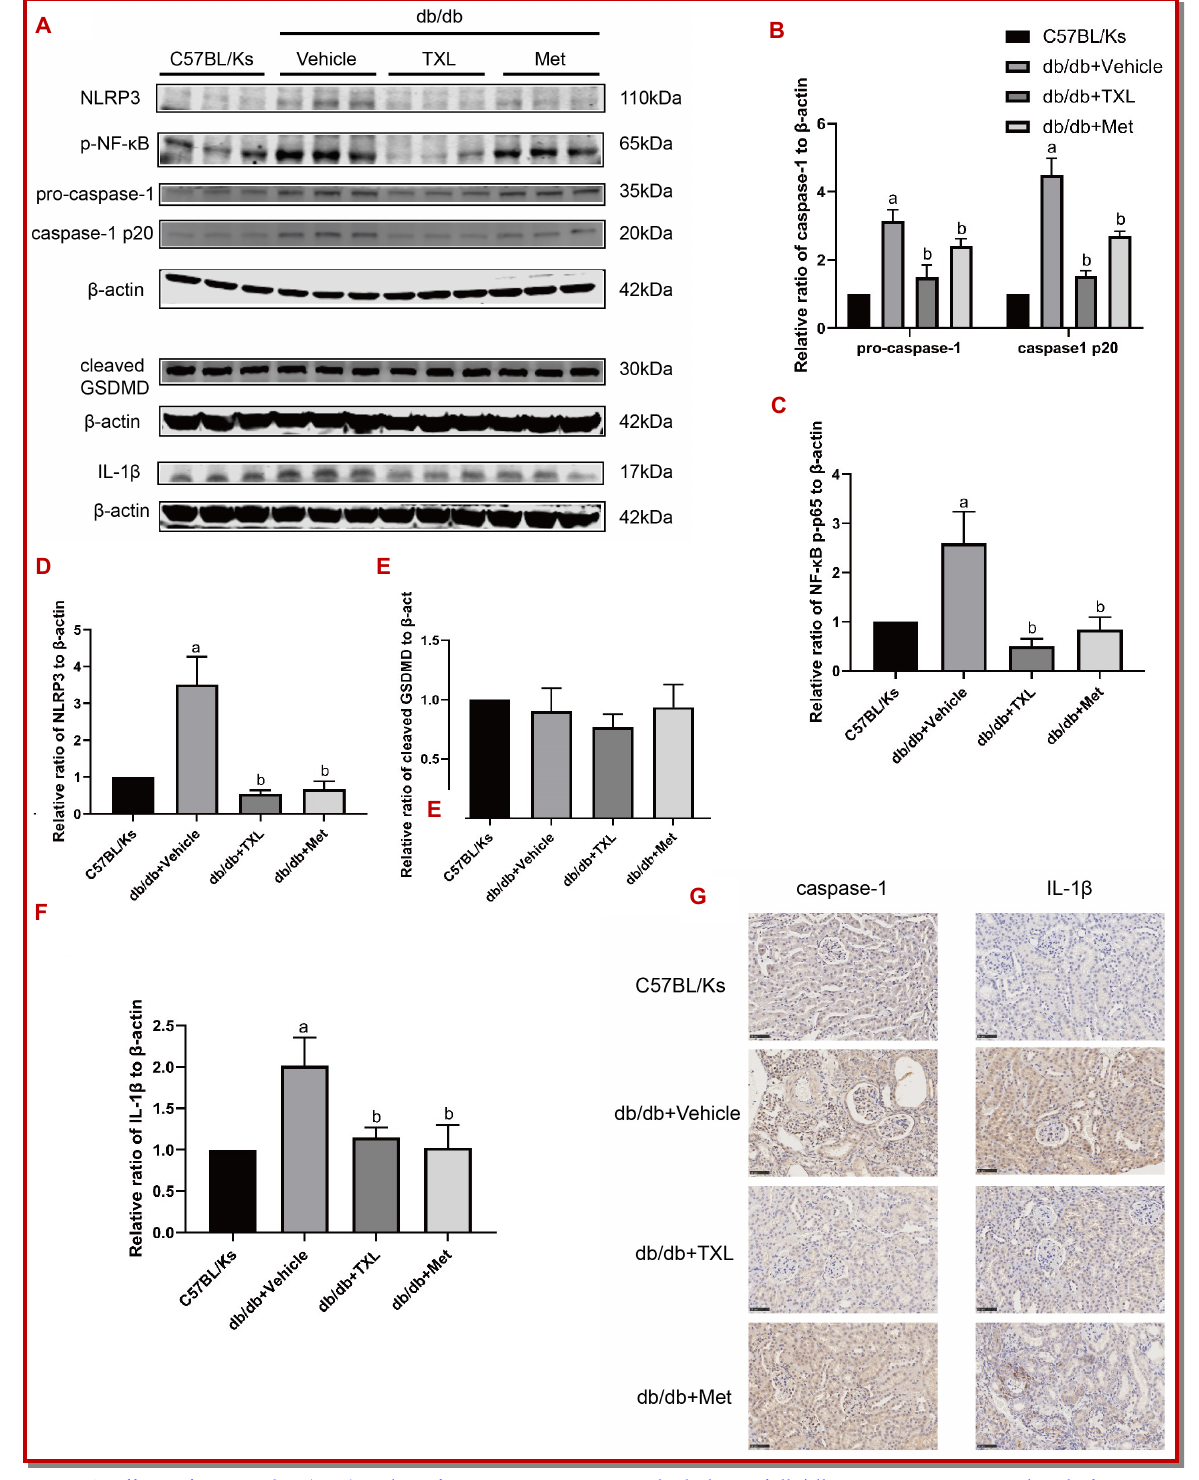
Figure 8: Effects of Tongxinluo (TXL) and metformin on pyroptosis in the kidney of db/db mice. Representative band of NF- κ B p- p65, NLRP3, caspase-1, cleaved GSDMD and IL-1 β by Western blot in the kidneys in the different groups of mice (n=3 per group) (A); Semiquantitative analysis of average optical density of NLRP3, p-NF κ B, Caspase-1, cleaved GSDMD and IL-1 β (B~F). The values represent means ± SEM. a p<0.05: the significant difference with respect to C57BL/Ks control; b p<0.05: the significant differ- ence with respect to undertreated db/db mice (model group). Immunohistochemical staining was performed to analyze the ex- pression of caspase-1 and IL-1 β (×400) in renal cortex from mice. Scale bar, 50 μ m